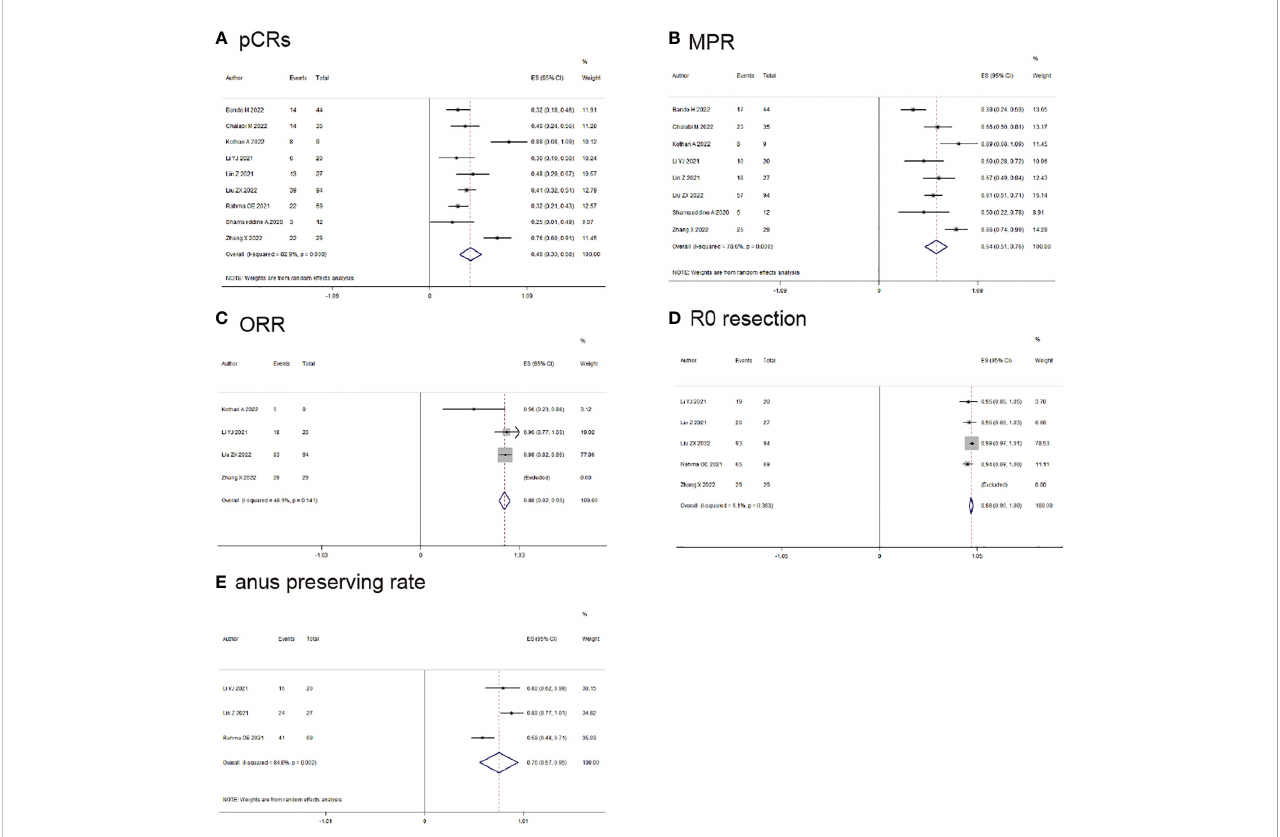
FIGURE 2 Primary outcomes of neoadjuvant immunotherapy for non-metastatic colorectal cancer. (A) pathological complete response (pCRs); (B) major pathological response(MPR); (C) objective response rate (ORR); (D) RO-resection; (E) anus preserving